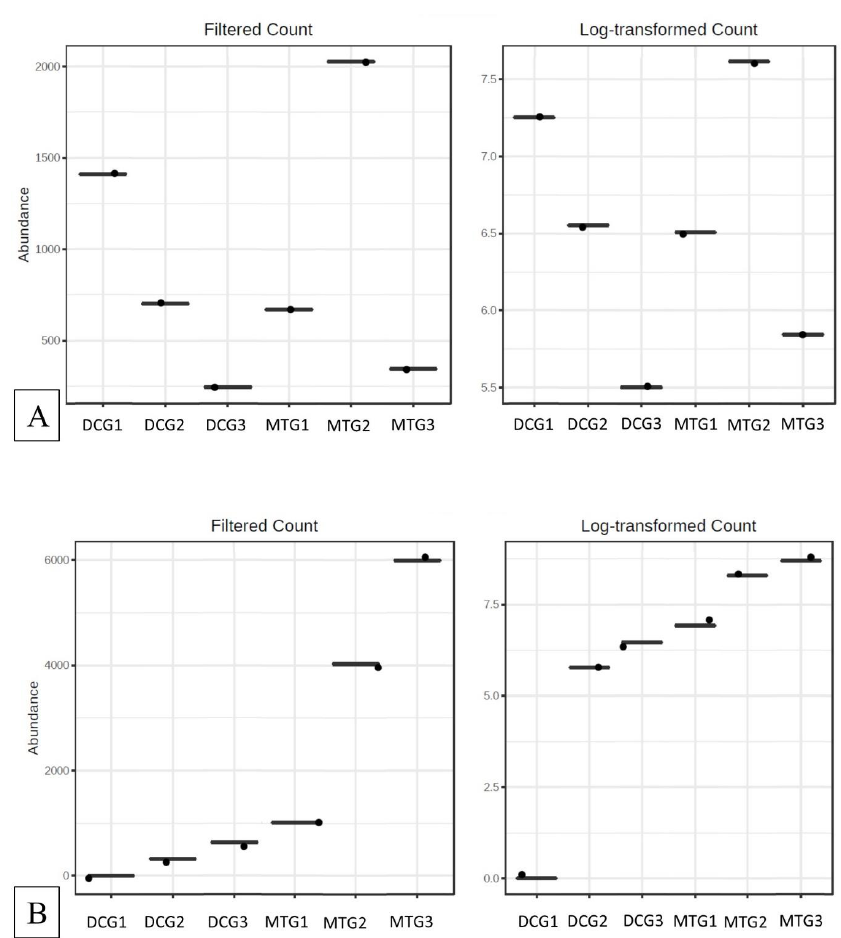
Figure 7. Differential abundance statistical analysis for ( A ) Penicillium and ( B ) Trichoderma species, in the DC/MT generations.